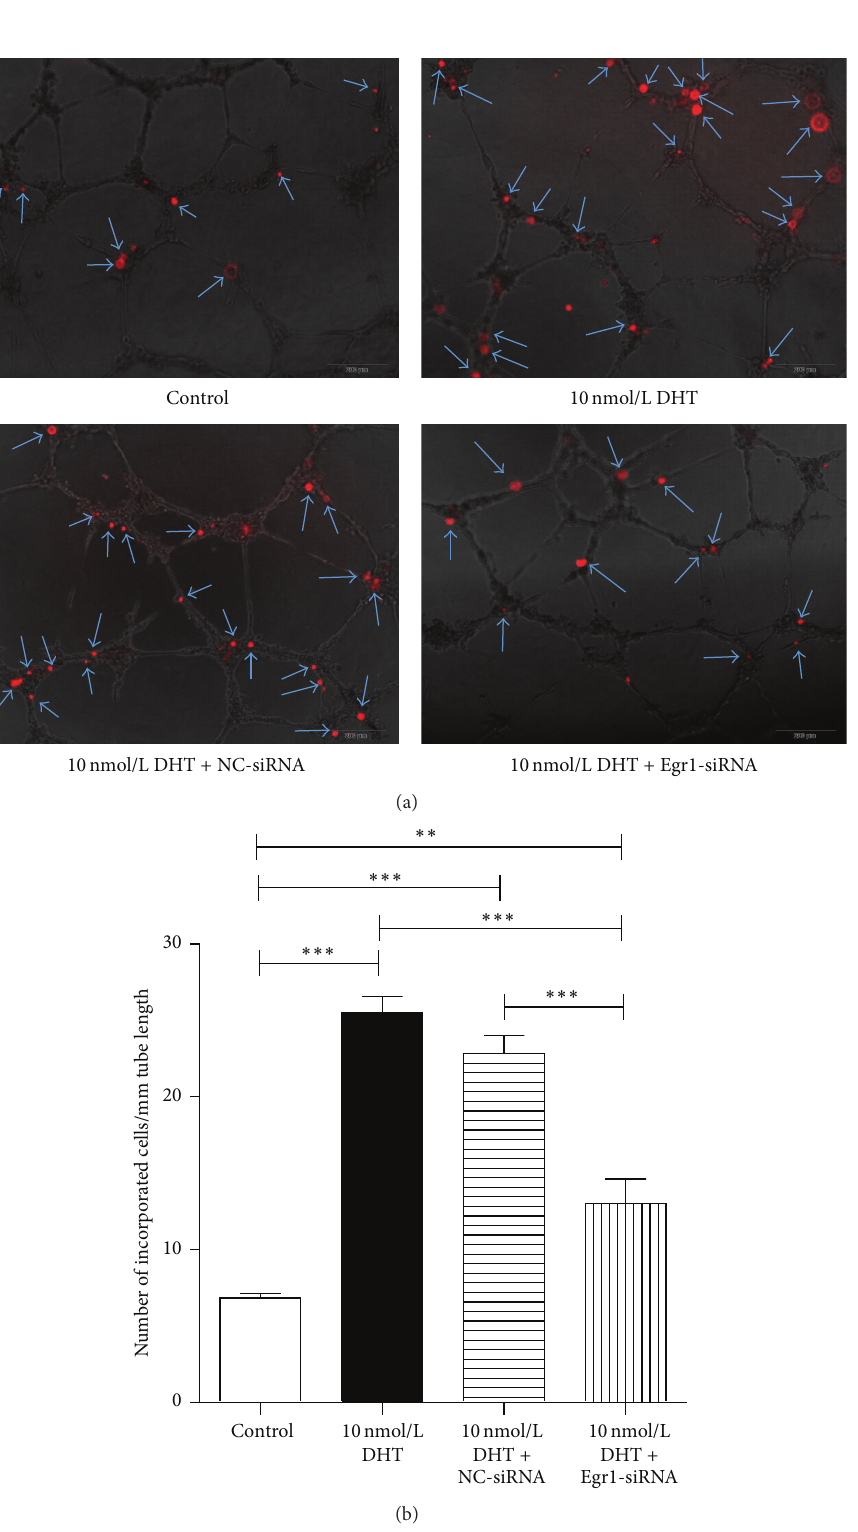
Figure 9: The in vitro incorporation assay of Egr1-silenced EPCs. Our data showed that Egr1-siRNA attenuated the boosting effects of DHT on the incorporation function of EPCs. (a) Incorporated DiI positive cells were indicated by arrows. (b) Number of incorporated cells into tube-like structures was counted and averaged. All assays were triplicated and demonstrated similar results. Data are presented in mean ± SD format. ∗∗ 𝑃 < 0.01 versus control group, ∗∗∗ 𝑃 < 0.001 versus control